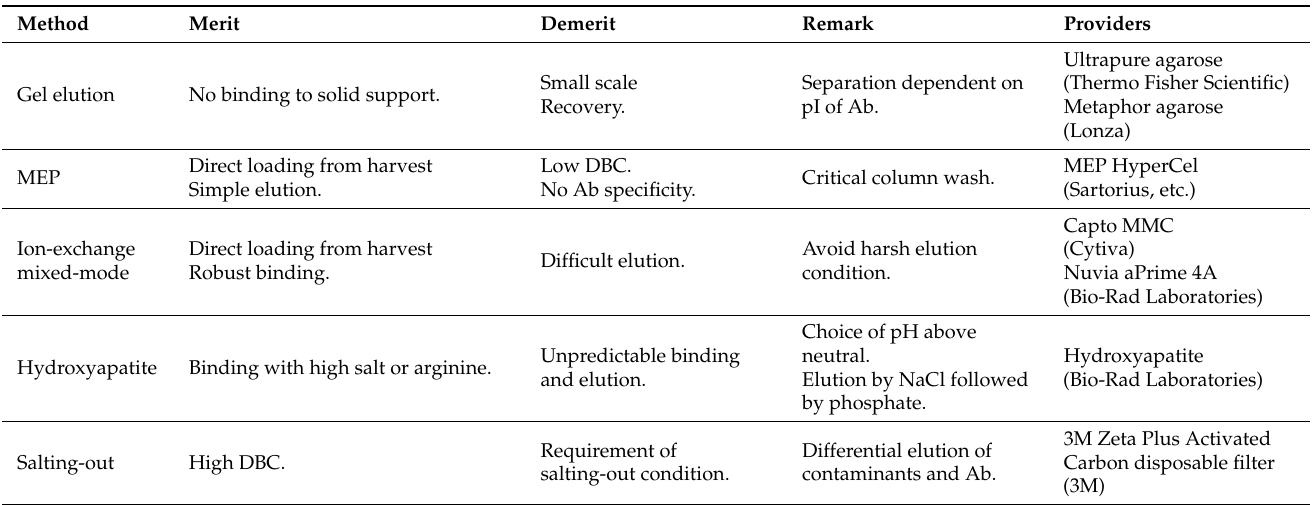
Table 1. Merits and demerits of non-affinity antibody